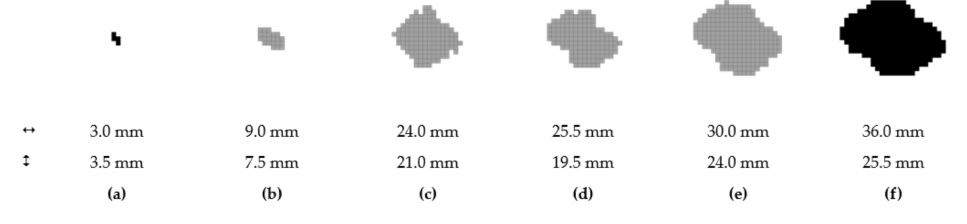
Figure 12. Damaged area at layer no. 1; 0.5 J ( a ); 1.0 J ( b ); 2.5 J ( c ); 5.0 J ( d ); 7.5 J ( e ); 10.0 J ( f ).